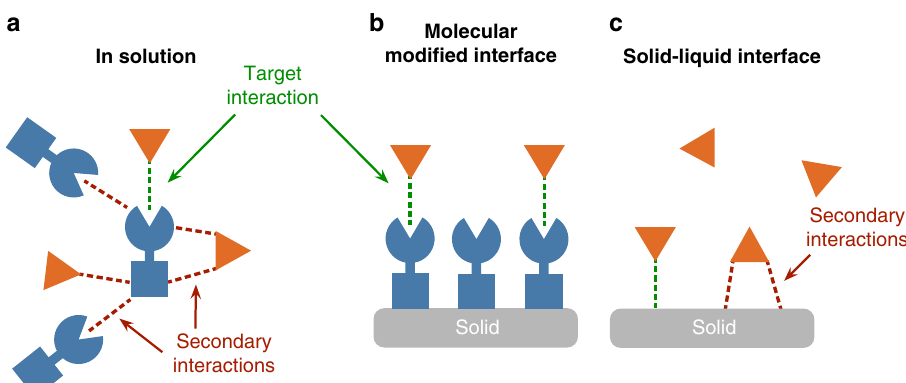
Fig. 1 Intermolecular interactions in solution and at the interface. A schematic representation of a generic molecule (blue) interacting with a substrate in solution (orange). a In solution, many possible interaction sites on the molecule are exposed. b When the molecule is anchored to a solid surface, secondary interaction sites are blocked by adjacent molecules. c In the absence of a surface-anchored molecular species, the interactions between the substrate and the surface are dif fi cult to conclusively de